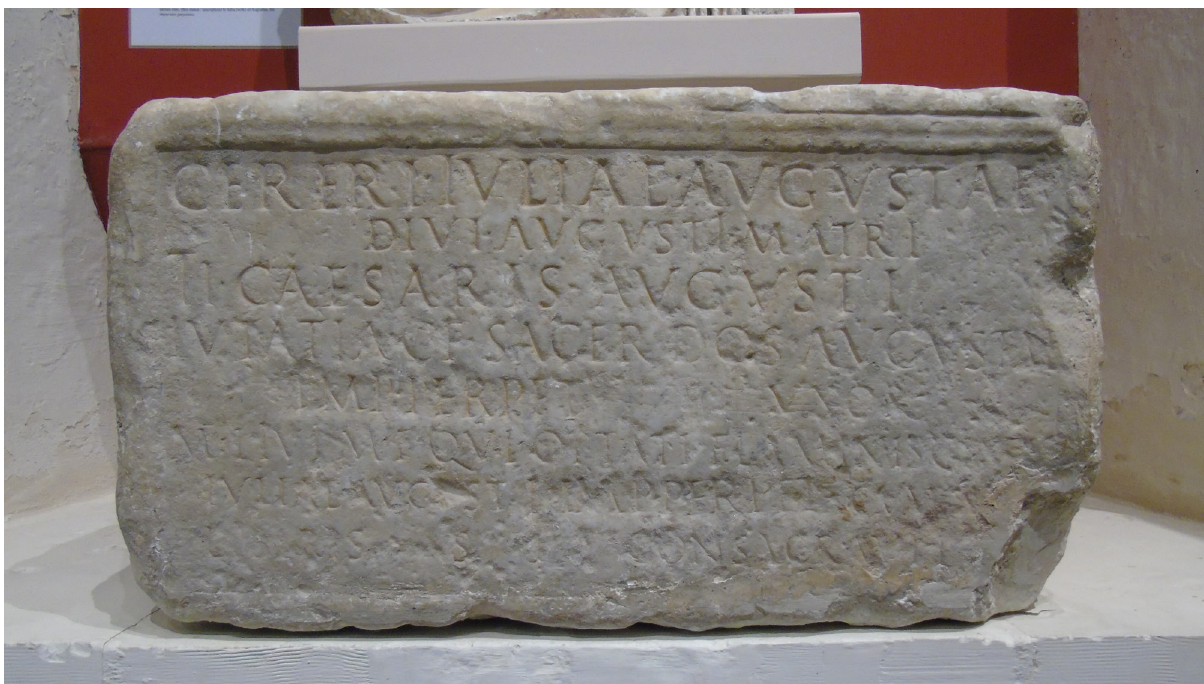
Figure 1: Dedication to the empress Livia (CIL X.7501) (Photo: author, courtesy of the Gozo Museum of Archaeology).